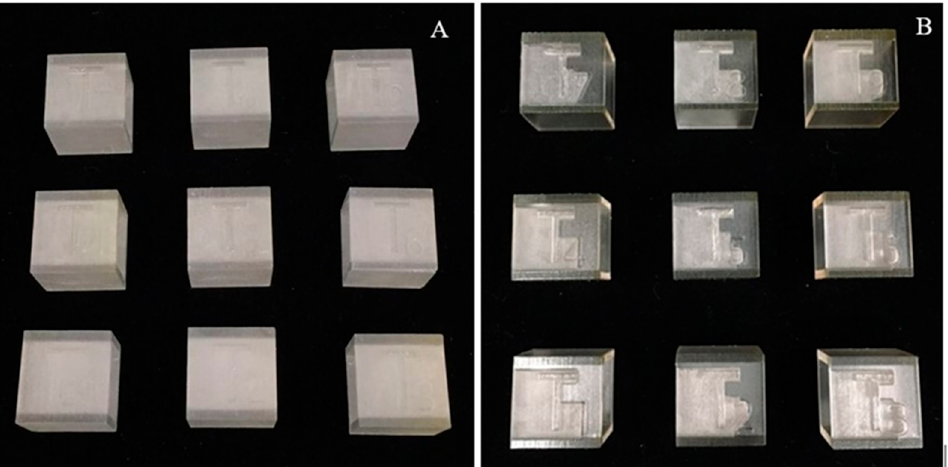
Figure 2. 3D printed test bodies after removal of support material: ( A ) Group 1 (PolyJet Matte) test bodies (T1–T9); and ( B ) Group 2 (PolyJet Glossy) test bodies (T1–T9).